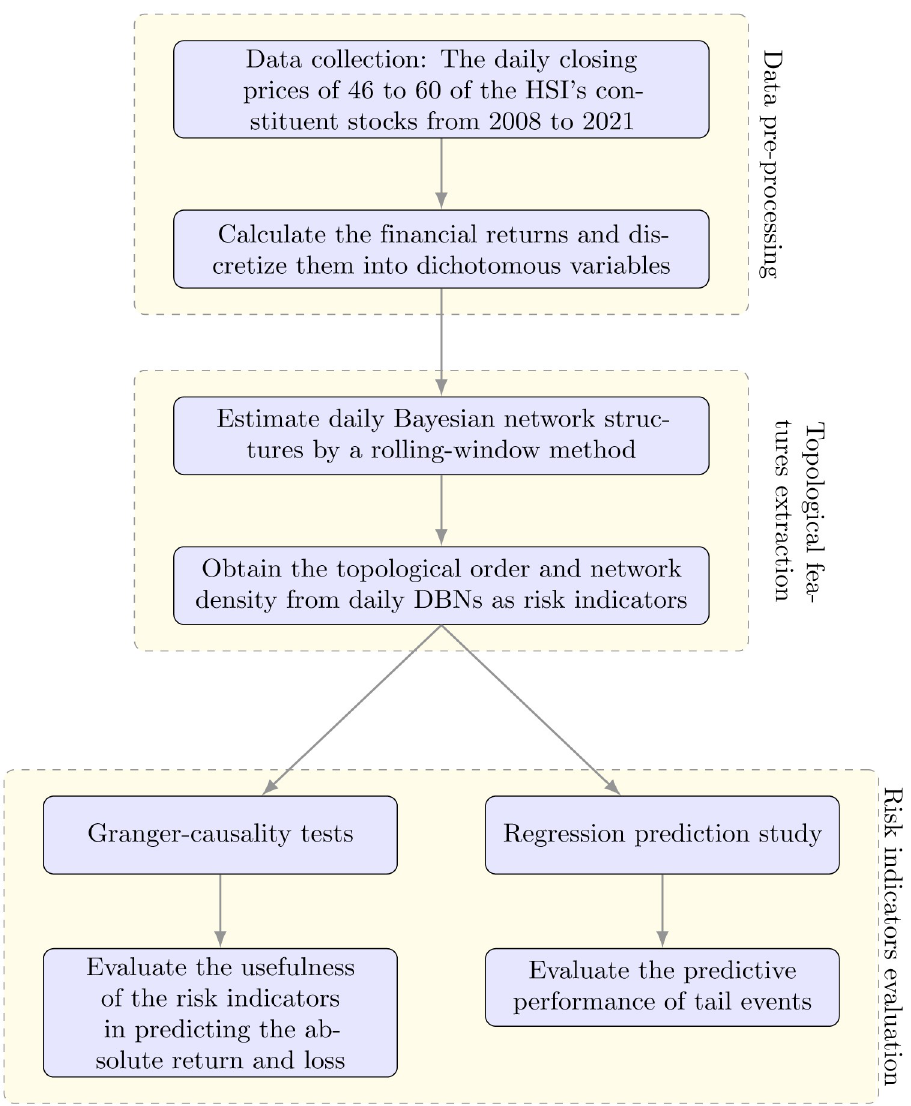
Fig 1. An overview of the methodology flow in our